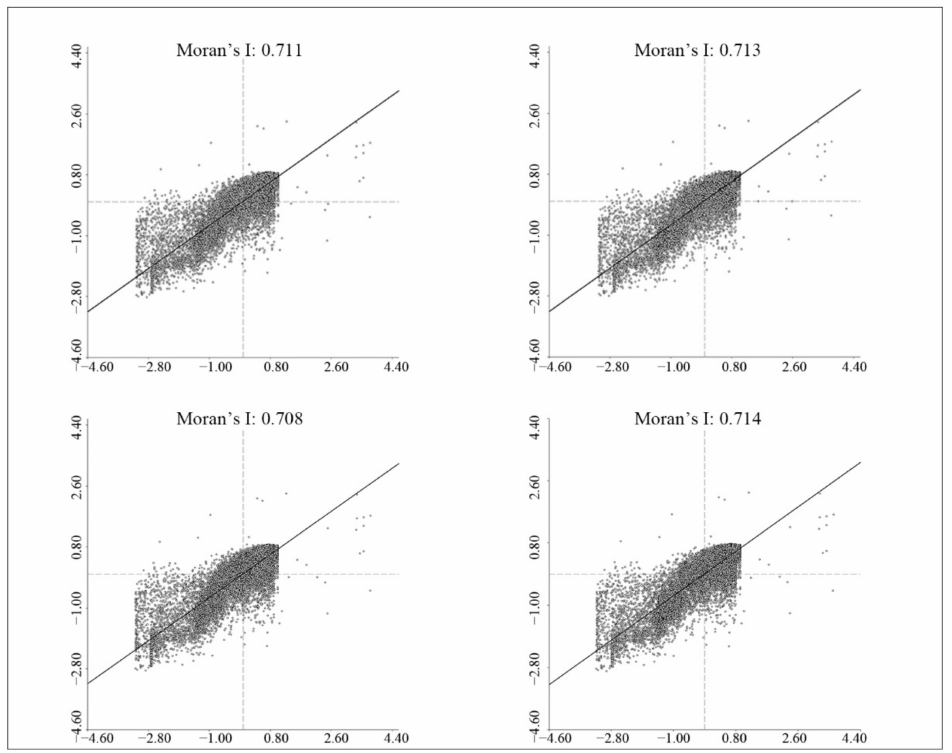
Figure 9. Moran scatter charts of the carbon storage in Hangzhou under the four scenarios in